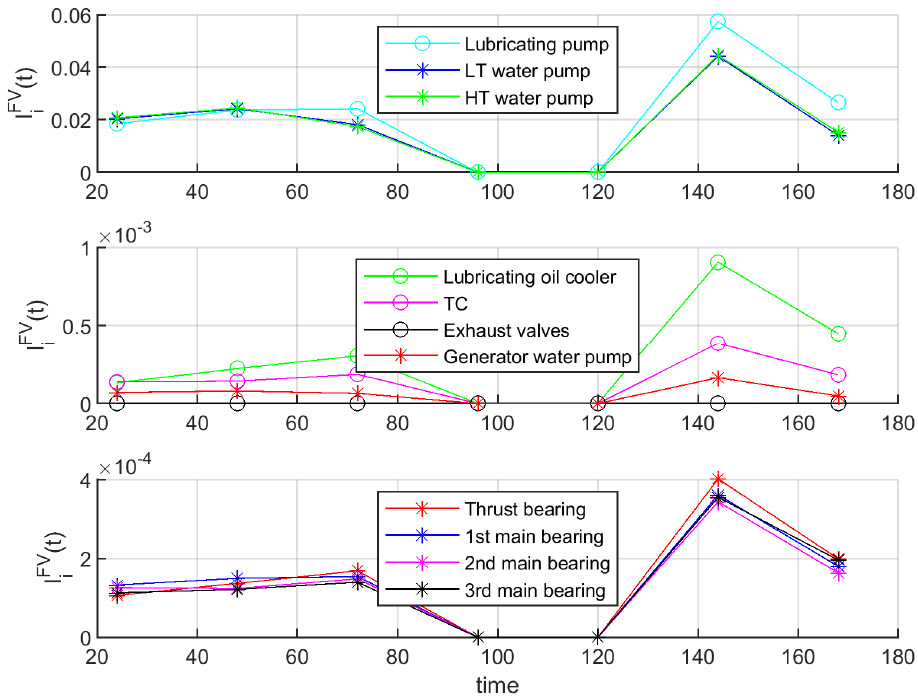
( t ) for different components of DG1 (horizontal axis is in hours). (Note: Figure 6. I FV Figure 6. (cid:1835) (cid:3036)(cid:3007)(cid:3023) ((cid:1872)) for different components of DG1 (horizontal axis is in hours). (Note: importance i importance measures points are connected with lines for facilitating the results measures points are connected with lines for facilitating the results visualisation.)